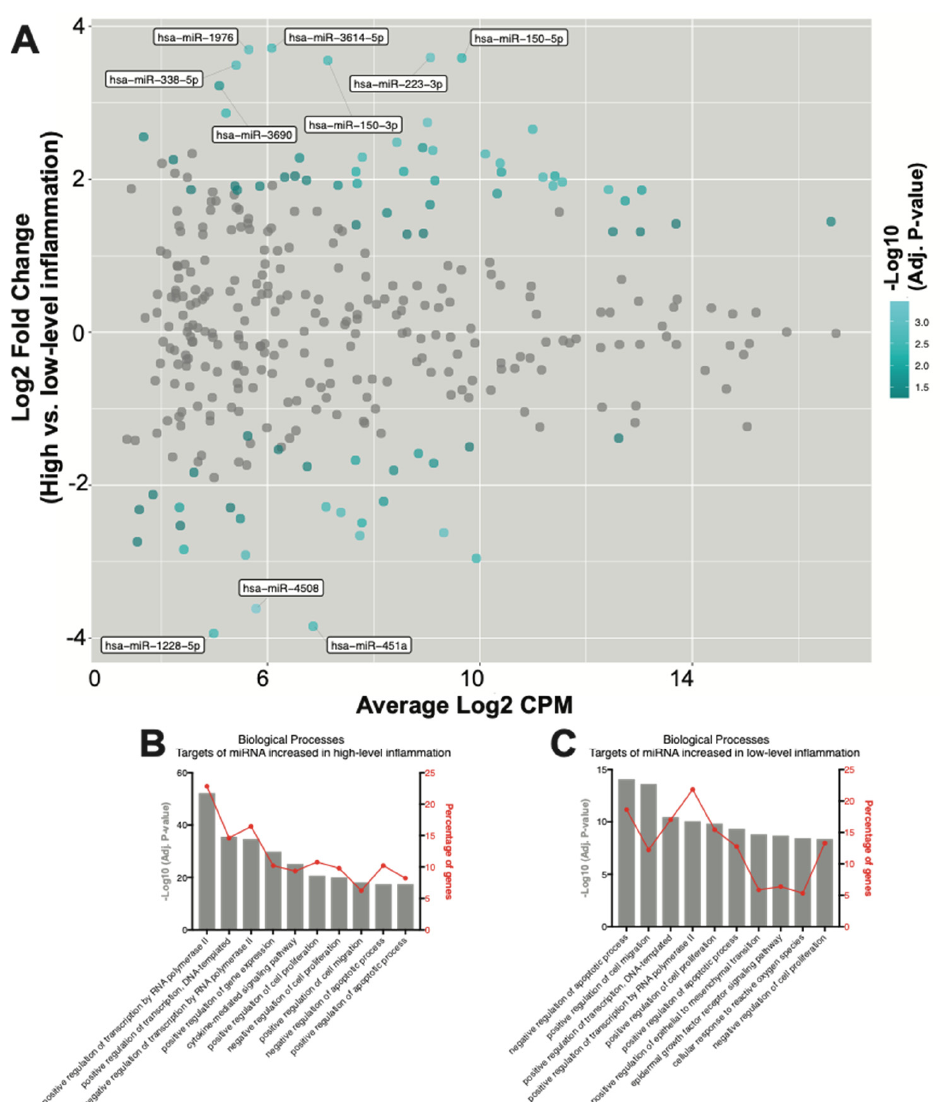
Figure 3. SF EV miRNAs have diverse immunoregulatory capacities. ( A ) MA plot of miRNA counts per million reads (CPM) vs. fold change. Differentially expressed miRNAs with an adjusted p -value < 0.05 are highlighted in blue. miRNAs with an adjusted p -value < 0.05 and a log2 fold change >3 are labelled. ( B – C ) Biological processes associated with target genes of the miRNAs significantly increased in joints with (B) high-, and (C) low-grade inflammation. The percentage of target genes asso- ciated with each biological process is